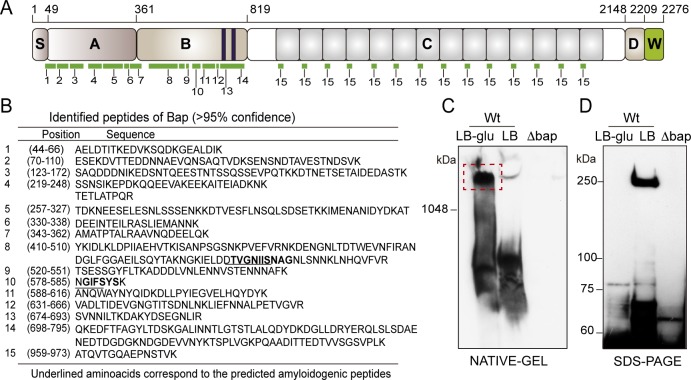
Proteolytic cleavage of Bap protein allows the formation of Bap-aggregates.A) Structural organization of Bap. S, signal peptide; A, region A; B, region B; C, repetition region; D, region of serine-aspartate (SD) repeats; W, cell wall anchor. Green lines correspond to peptides obtained by the MS analysis of the Bap-related insoluble aggregates. B) Summary of the peptides corresponding mostly to the N-terminal region of Bap as identified by MS analysis. Amino acid sequences and positions of identified peptides are shown. C) Insoluble material retained in the native gel pocket that was subjected to MS analysis. Samples were separated in Criterion XT Tris-acetate gels with Tris/glycine running buffer and probed with anti-Bap antibodies. D) Cell wall extracts from S. aureus V329 stationary culture (OD≈5) grown in LB-glu or LB were separated on 3–8% Criterion Tris-acetate acrylamide gels and probed with anti-Bap antibodies specifically raised against domain B.